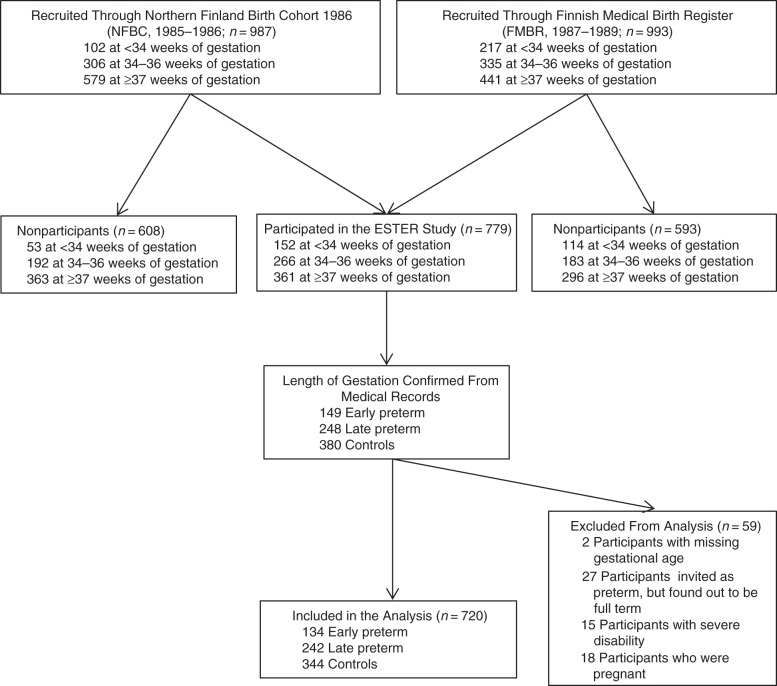
Flow chart of the study population, Northern Finland, 2009–2011. All subjects who were recruited into the study were born in Northern Finland in 1986–1989. In the Finnish Medical Birth Register data, there were 83 individuals in the random control group who had missing gestational age, 58 of whom did not participate in the Preterm Birth and Early Life Programming of Adult Health and Disease (ESTER) Study and 25 of whom participated. Ten subjects who were born early preterm, 1 subject who was born late preterm, and 4 controls reported severe disability and were excluded from the analysis. Five subjects who were born early preterm, 5 subjects who were born late preterm, and 8 controls reported being pregnant and were excluded from the analysis. Three of the excluded subjects had more than 1 reason for exclusion.